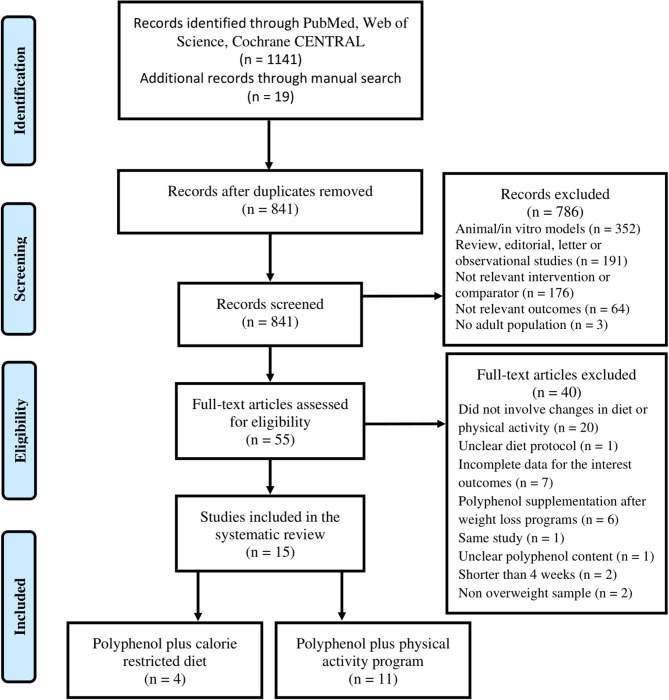
Study selection.